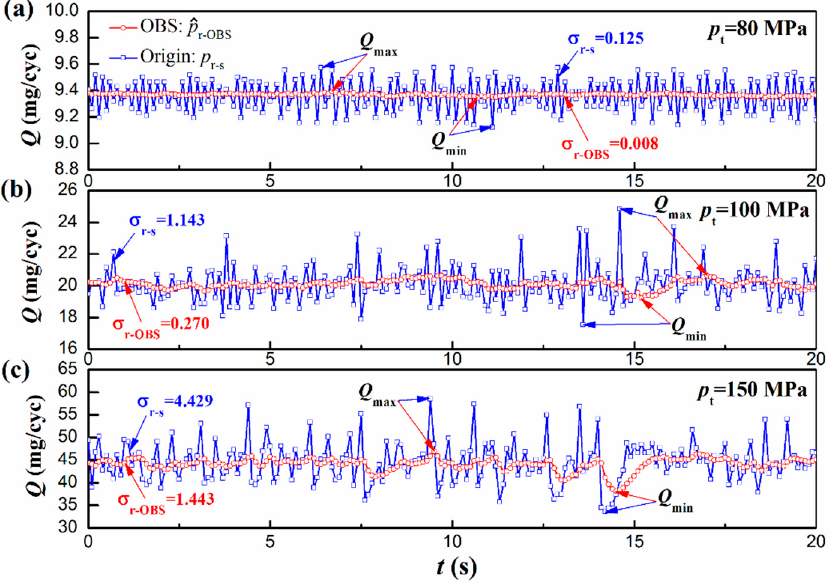
Figure 7. Measured injected quantity of 200 injection cycles for ˆ p r − OBS and p r − s under three different target pressures of ( a ) p t = 80 MPa, ( b ) p t = 100 MPa, and ( c ) p t = 150 MPa. The cycles of maximum and minimum injected quantity are indicated in the graphs.